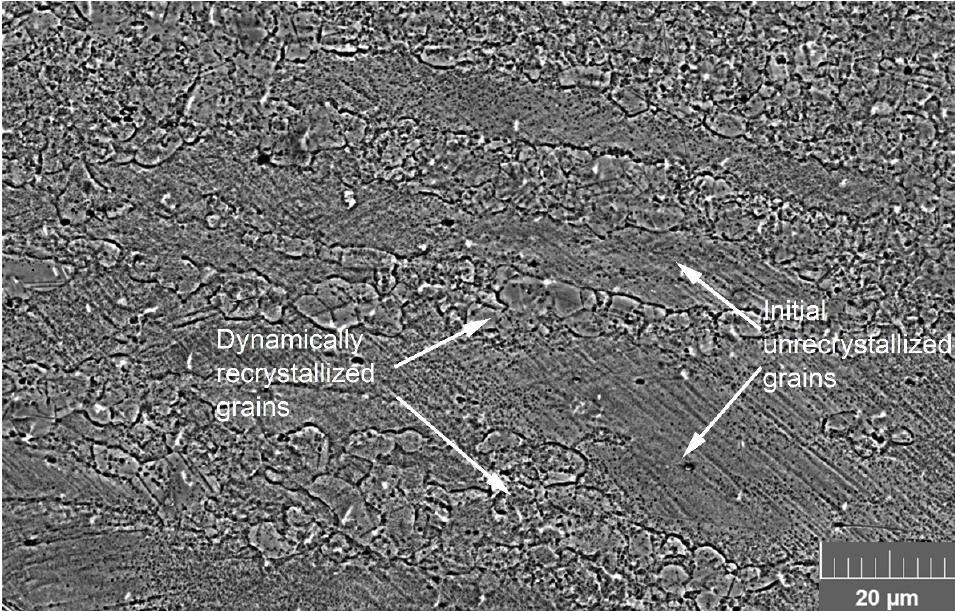
Figure 9. The partially recrystallized microstructure after the deformation at 950 °C and 10 s − 1 .